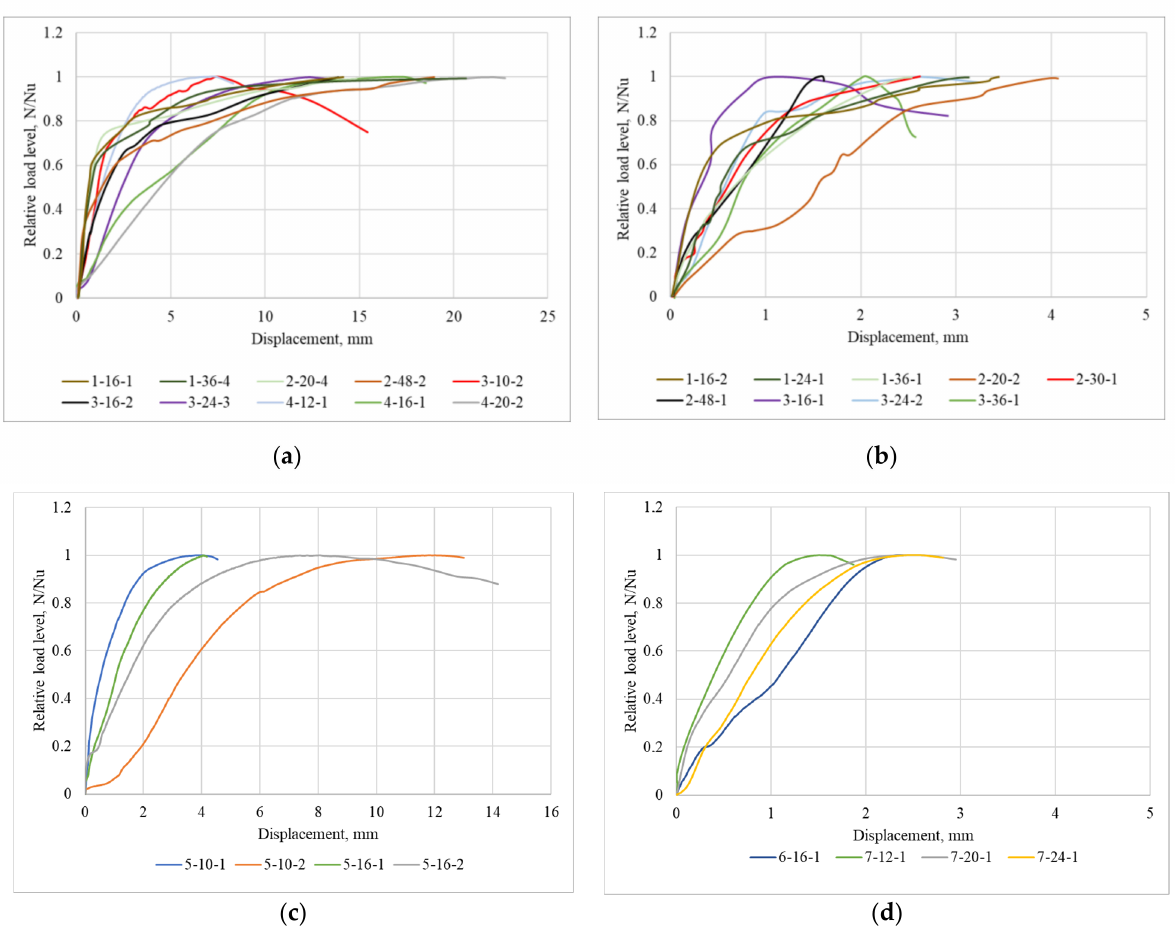
Figure 10. Load-displacement relationships under the static loading that triggers various anchorage failure mechanisms: ( a ) anchor material (steel) failure; ( b ) base concrete failure; ( c ) (5-10-1 and 5-16-1) slippage in the base and (5-10-2 and 5- 16-2) slippage followed by the failure of the base concrete; ( d ) failure at the interface between the adhesive composition and the